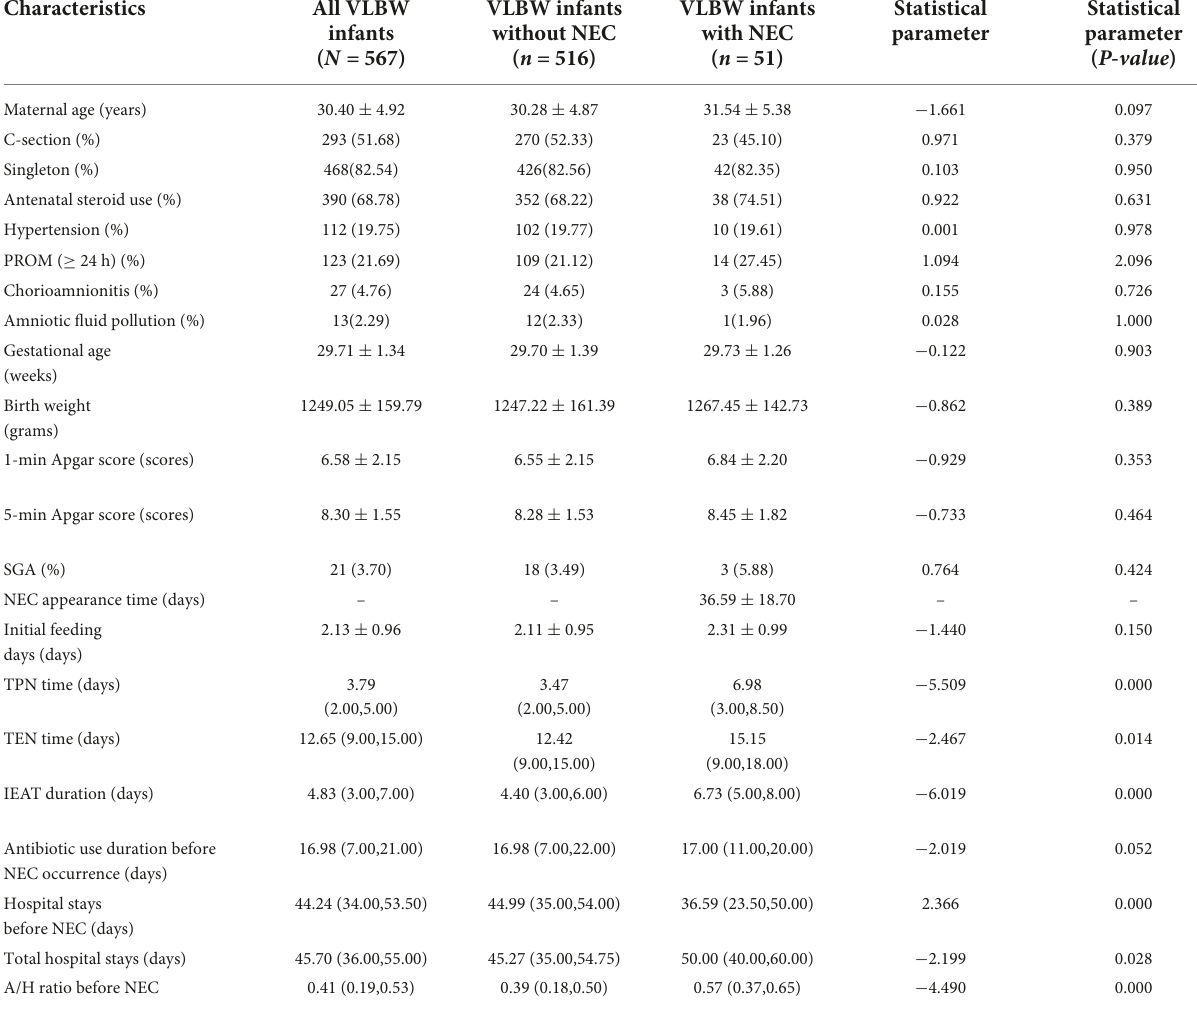
TABLE 1 Clinical characteristics of VLBW infants with and without